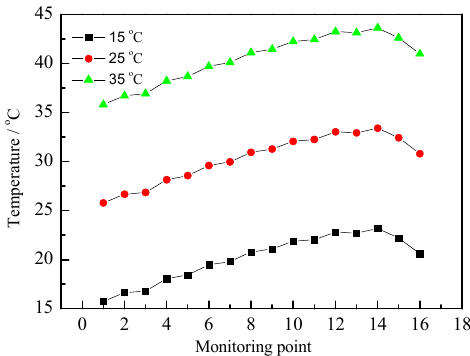
Figure 9. Comparison of the temperature rise for different discharge air intake temperatures (15, 25 and 35 °C) at a constant inlet velocity (1.0 m/s) and 1C discharging rate. Table 2. Temperature rise and temperature differences for different air inlet temperatures.